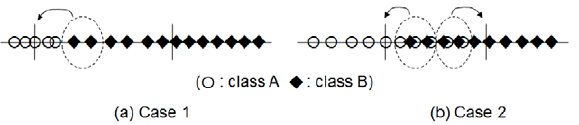
Figure 4. Two cases that CScore() produces wrong scores. If data range of a class is so smaller than neighbor class’, CScore may produce wrong score (Case 1). If two classes’ have wide overlapping area, CScore may produce wrong score (Case